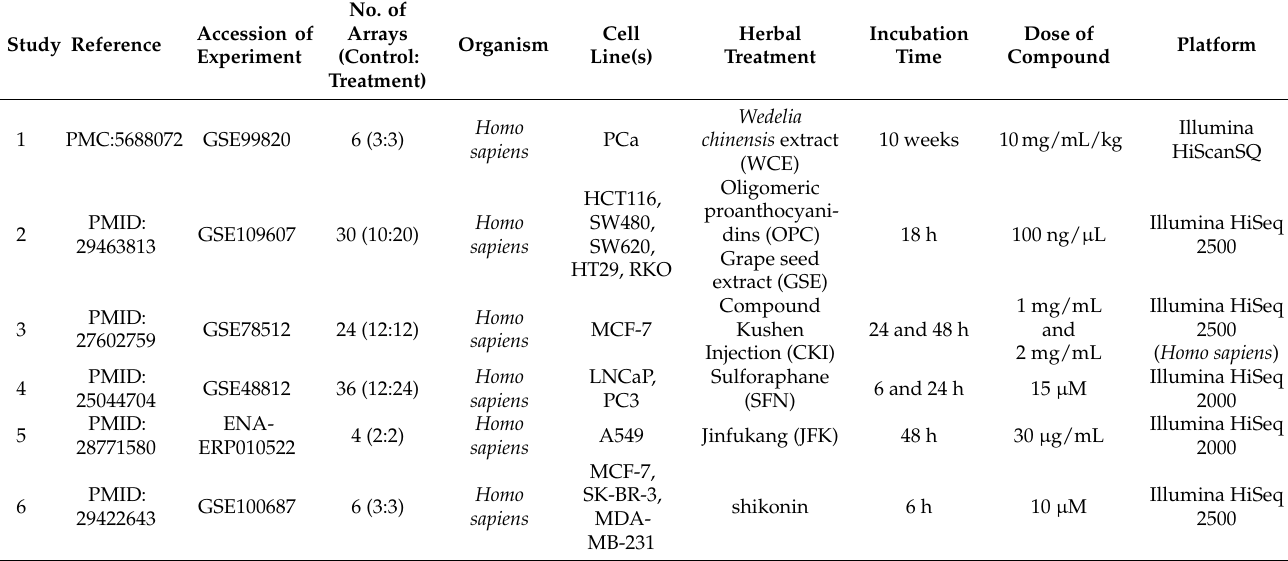
Table 1. Studies and samples employed in this investigation to find a regulatory signature of transcription factors responding to different herbal compounds in various carcinogenic